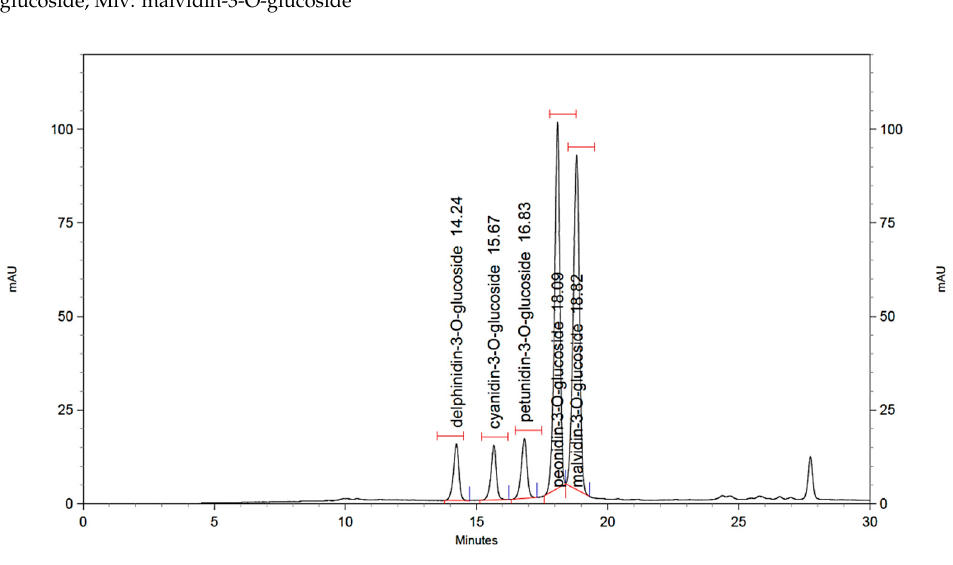
Figure 1. Characteristic chromatogram of a real sample spiked at 1 mg/kg concentration level, monitored at 520 nm.